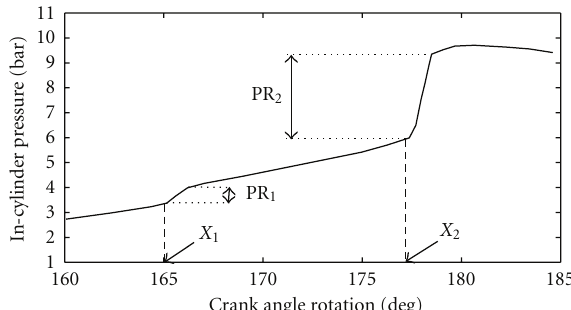
Figure 2: A typical pressure trace showing two-stage combustion.